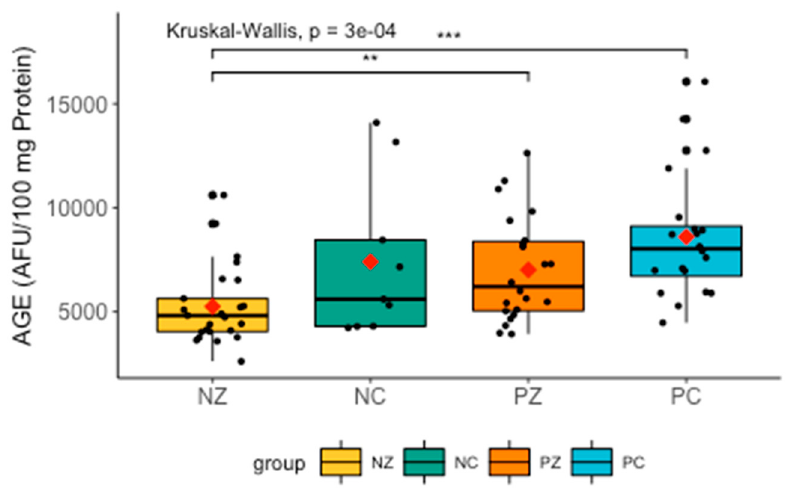
Figure 8. Levels of AGE in the examined groups. AGE, advanced glycation end-products; NZ, generally healthy patients without the BRCA1 mutation; NC, patients with breast cancer but without the BRCA1 mutation; PZ, generally healthy patients with the BRCA1 mutation; PC, patients with both breast cancer and the BRCA1 mutation. ** p < 0.01; *** p < 0.001.